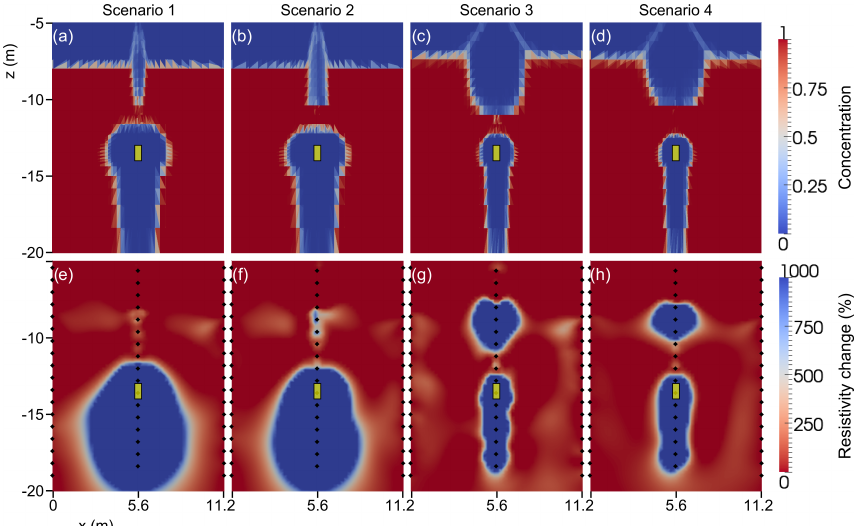
Figure 11. Comparison of simulation results for different hydraulic conductivity parameterizations at time 4.2h after start of injection. The top panel shows the flow and transport modeling results, the bottom panel the corresponding simulated ERT results; (a) and (e) homogeneous model, (b) and (f) fine layer within homogeneous model, (c) and (g) two-layered system, and (d) and (h) two-layered system including fine layer at